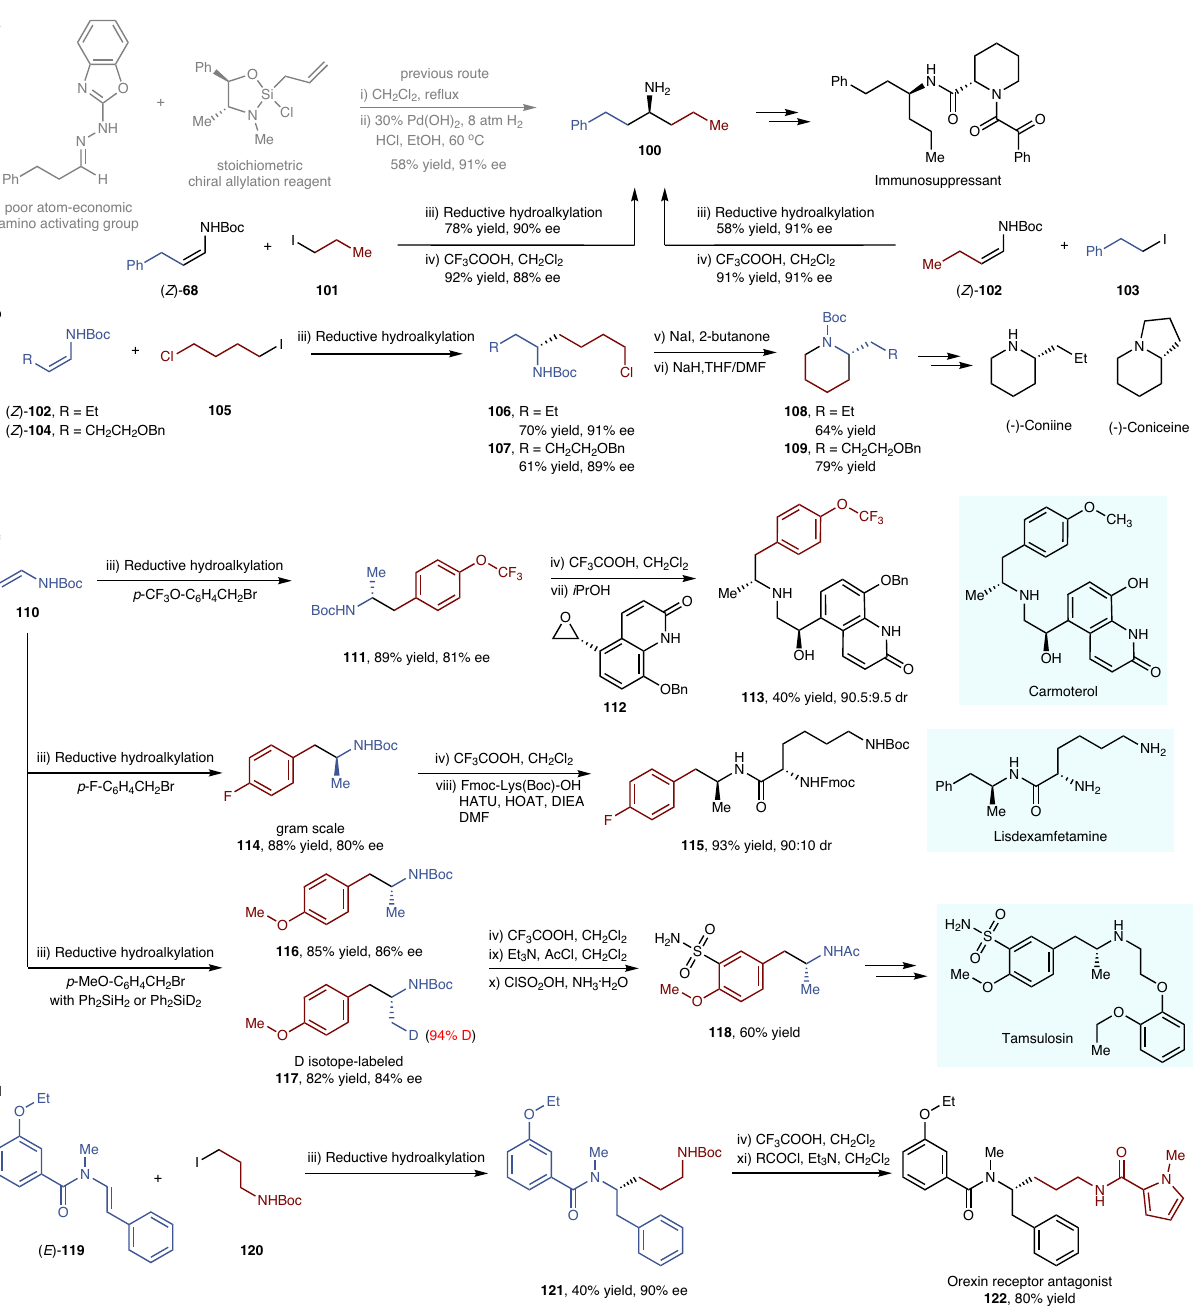
Fig. 6 Synthetic transformations of reductive hydroalkylation products. a Comparison of enecarbamate reductive hydroalkylation with conventional methods for the synthesis of the key intermediate of an immunosuppressant agent. b Synthesis of alkaloids with enecarbamate reductive hydroalkylation as a key step. c Modular synthesis of isotope- or fl uorine-labelled central nervous system drugs via enecarbamate reductive hydroalkylation. d Formal synthesis of drug analogues that contain a chiral carbon adjusted to a tertiary amide. All yields refer to isolated yield of puri fi ed product. For more details for reaction conditions, see Supplementary Note 1. THF = tetrahydrofuran, DMF = N , N -dimethylformamide, Fmoc = 9- fl uorenylmethoxycarbonyl, Fmoc- Lys(Boc)-OH = ( S )-2-((((9 H - fl uoren-9-yl)methoxy)carbonyl)amino)-6-(( tert -butoxycarbonyl)amino)hexanoic acid, HATU = 2-(7-azabenzotriazol-1-yl)- N , N , N ’ , N ’ -tetramethyluronium hexa fl uorophosphate, HOAT = 1-hydroxy-7-azabenzotriazole, DIEA = N , N